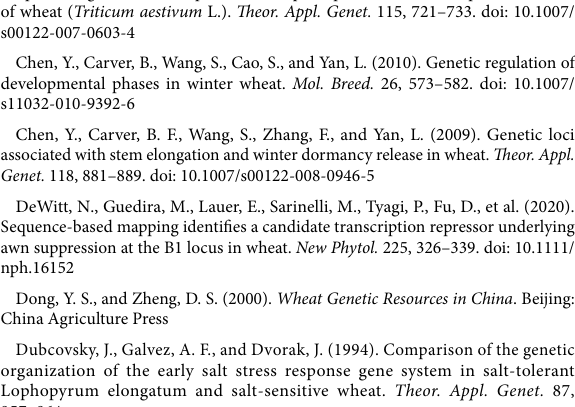
SUPPLEMENTARY TABLE S1 Detailed information for the length of each linkage group and genetic distances of the SNP markers on the whole